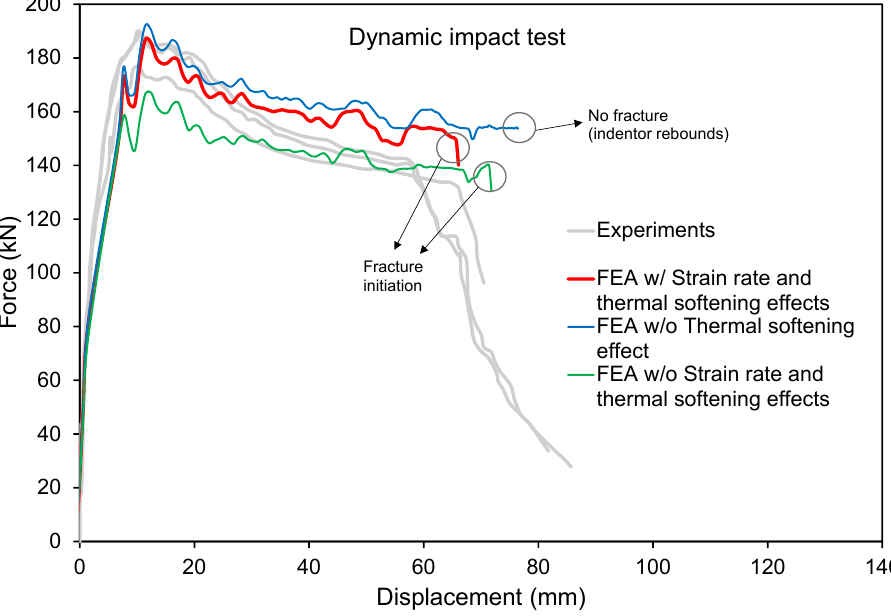
Figure 13. Force-displacement curves obtained considering or omitting dynamic